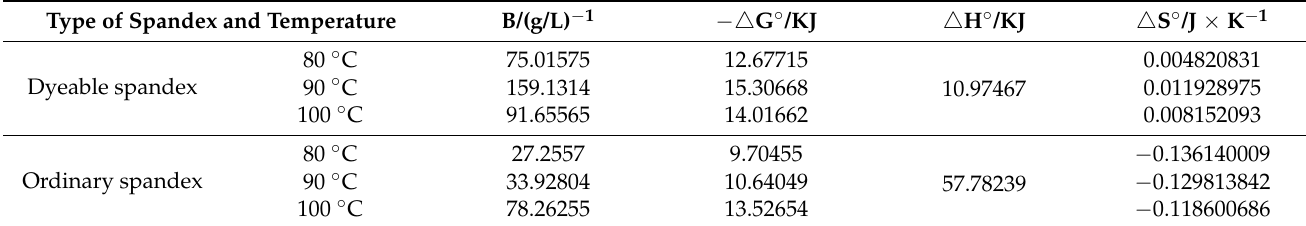
Table 5. Thermodynamic parameters of spandex dyed with neutral red